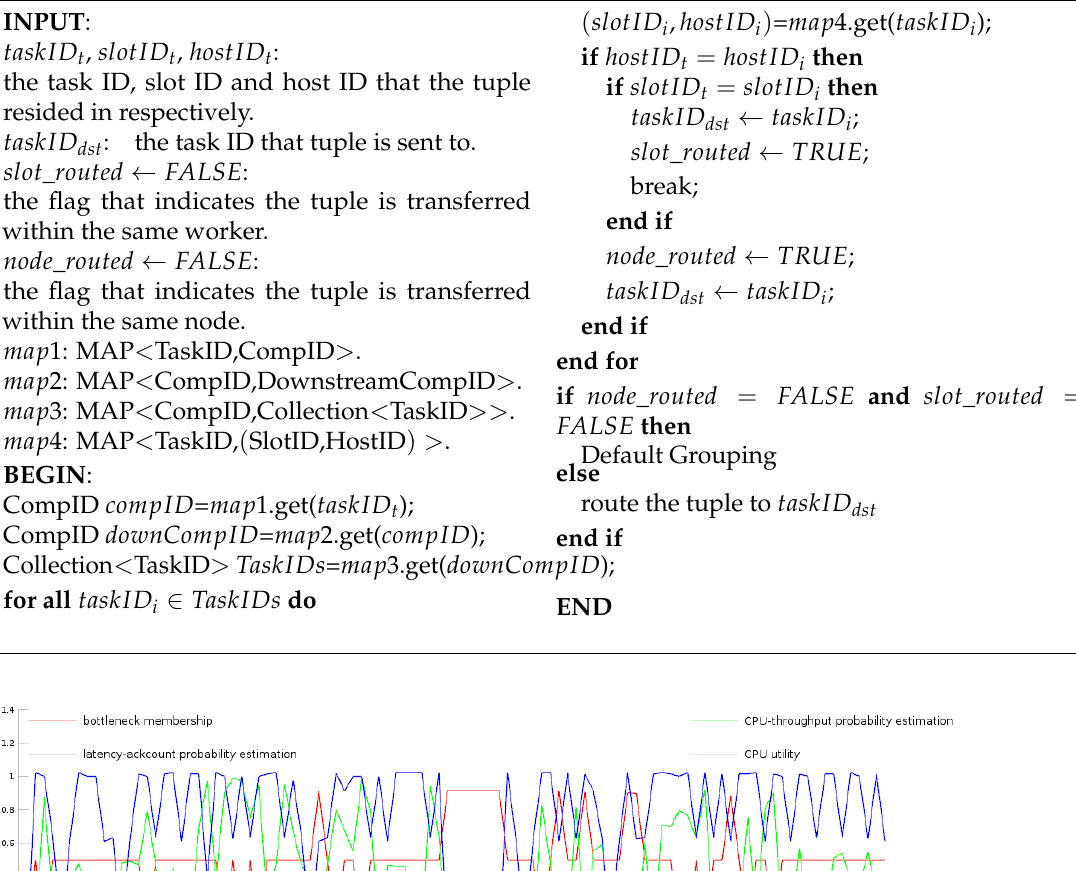
Algorithm 2 The routing algorithm.